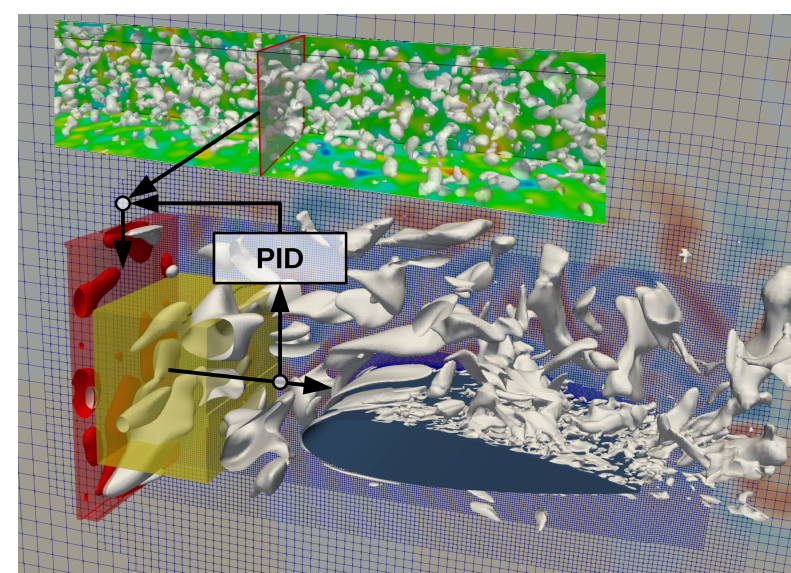
Figure 3. Sketch of forcing and controller. The synthetic fluctuations are taken from a slice of the separate fluctuation field and then introduced in the red forcing region (instantaneous force is indicated by red iso-surfaces), the resulting fluctuation velocity is then determined in the yellow control region and looped back via the PID